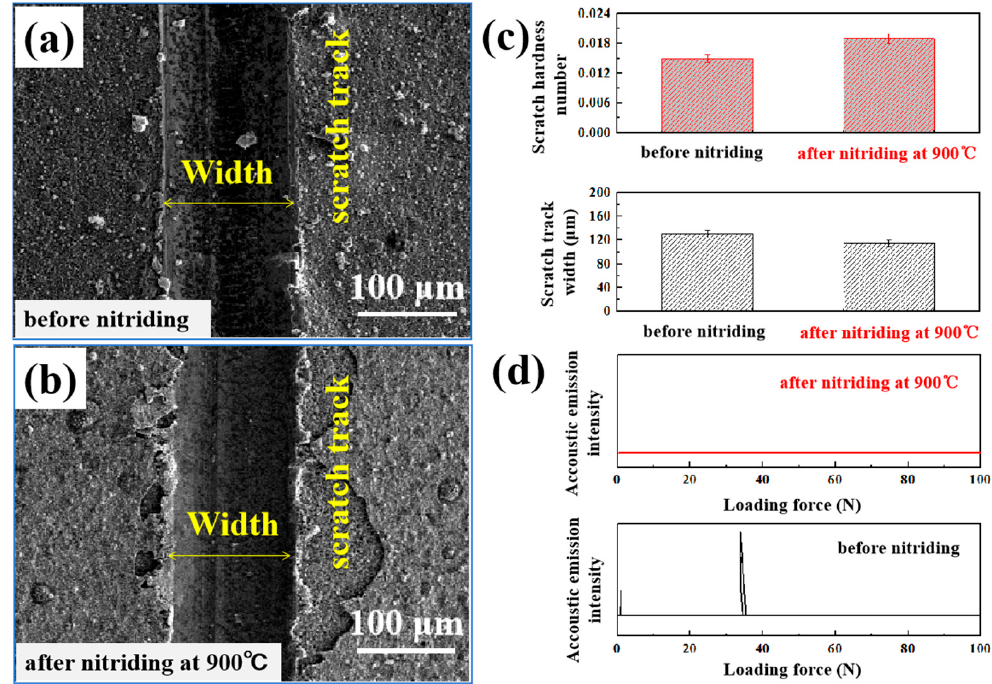
Figure 4. The scratch properties of the Ti/Cu multilayer film before and after nitriding: ( a , b ) scratch track morphologies, ( c ) scratch hardness number and track width, ( d ) critical loading force.